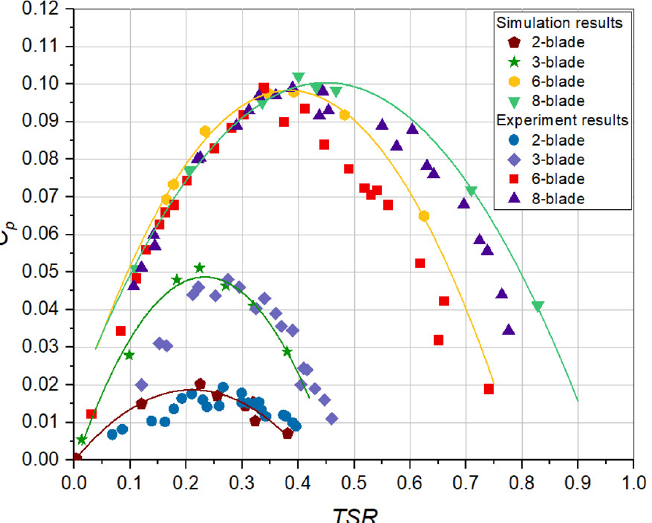
Figure 12. Effect of the number of blades on the power coefficient for different TSR values (experi- mental and simulation